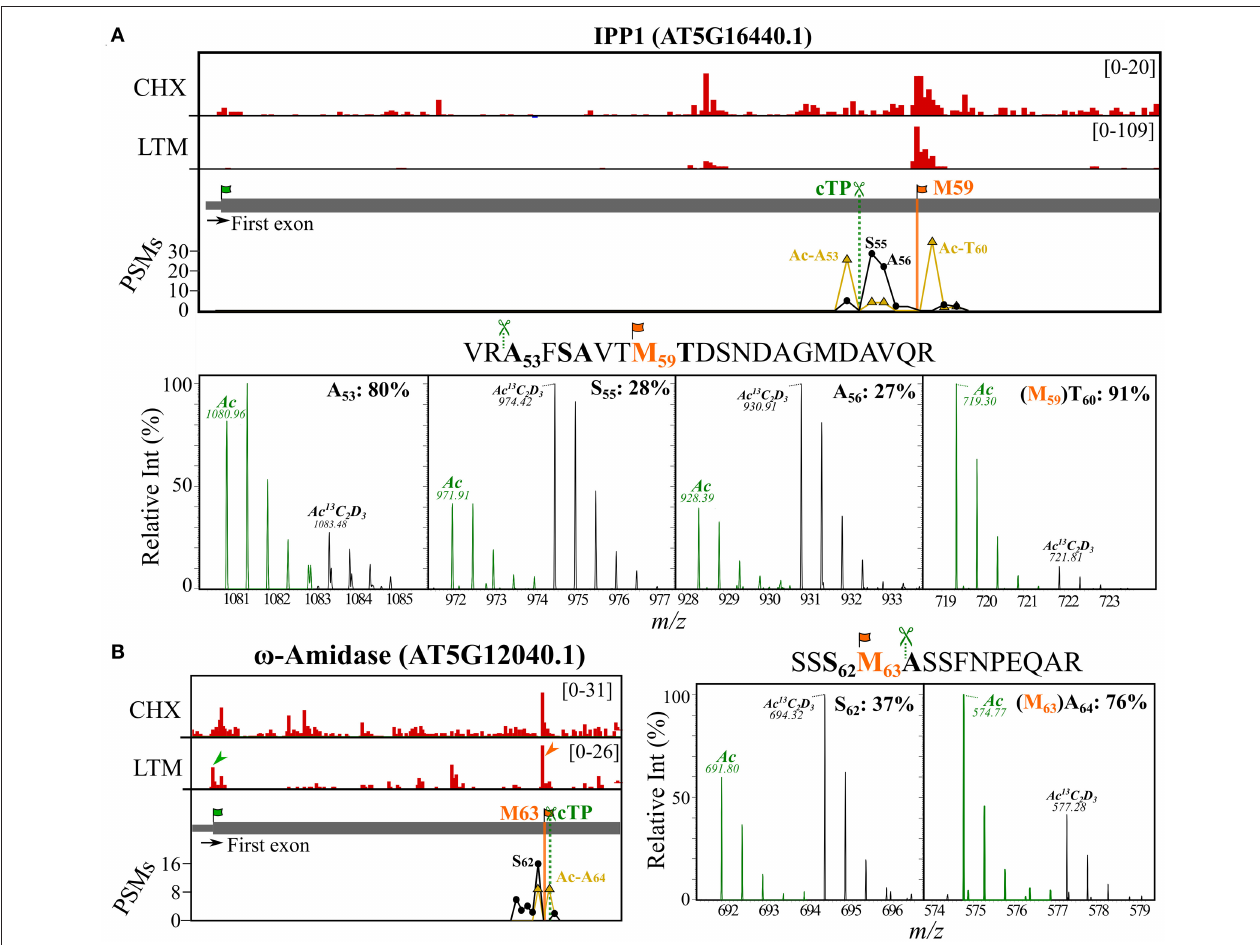
FIGURE 5 | Riboproteogenomic evidence indicative of proteolytic signal peptide processing and alternative TIS usage. Ribo-seq coverage and PSM counts of identified Nt peptides were plotted for the first exonic region of [ (A) , top] IPP1 (AT5G16440) and [ (B) , left] ω -amidase (AT5G12040). Genome view showing CHX and LTM strand-specific positional Ribo-seq data (red). Vertical lines indicate identified dTIS (orange) and the cTP predicted cleavage site (dark green, dotted line) ( Almagro Armenteros et al., 2019 ). LTM peaks corresponding to Ribo-seq-called dbTIS and dTIS were indicated by green and orange arrowheads, respectively. The PSM counts for the in vivo NTA (yellow) and in vitro 13 C 2 D 3 -NTA (i.e., in vivo Nt-free) (black) N-termini are plotted. MS1 spectra of uniquely identified NTA peptides originating from [ (A) , bottom] IPP1 (AT5G16440.1) and [ (B) , right] ω -amidase (AT5G12040.1). Isotopic envelopes matching the in vivo NTA (green) and in vitro Ac 13 C 2 D3 (black, + 5 Da) counterparts are shown for different NTA Nt peptides identified (peptide on top, bold residues). The calculated degree of NTA (%) was indicated together with the corresponding Nt residue. Predicted cTP cleavage motifs (P2–P1) preceding the identified Nt peptide sequences as well as the initiator Met (iMet) of riboproteogenomic-mapped dTIS (orange) were indicated in the sequence. All peptide precursors had a 2 + charge, and precursor m/z values are